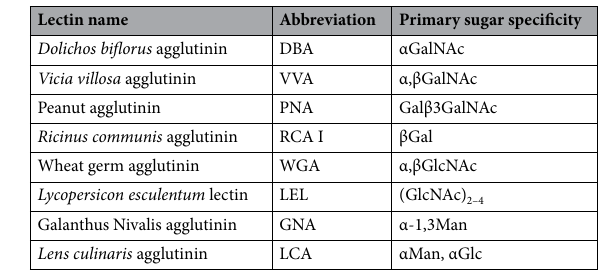
Table 1. List of the lectins used with their primary sugar specificity. Gal d-Galactose, GalNAc N -Acetylgalactosamine, Glc d-Glucose, GlcNAc N -Acetylglucosamine, Man